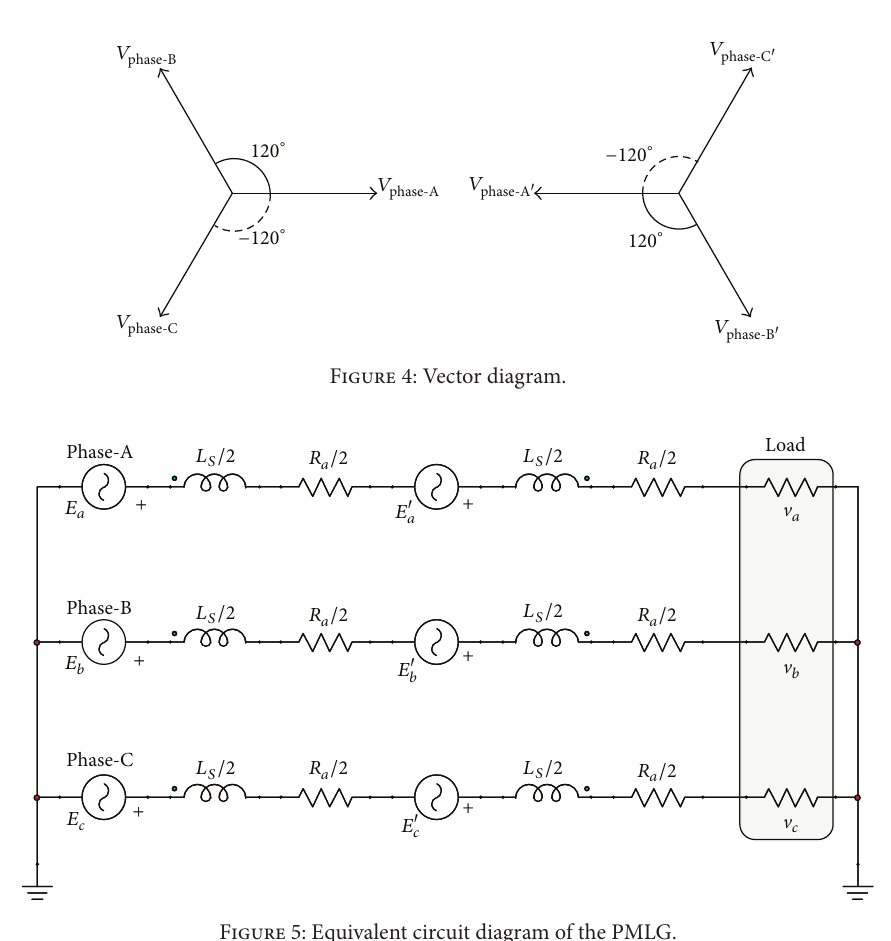
Figure 5: Equivalent circuit diagram of the